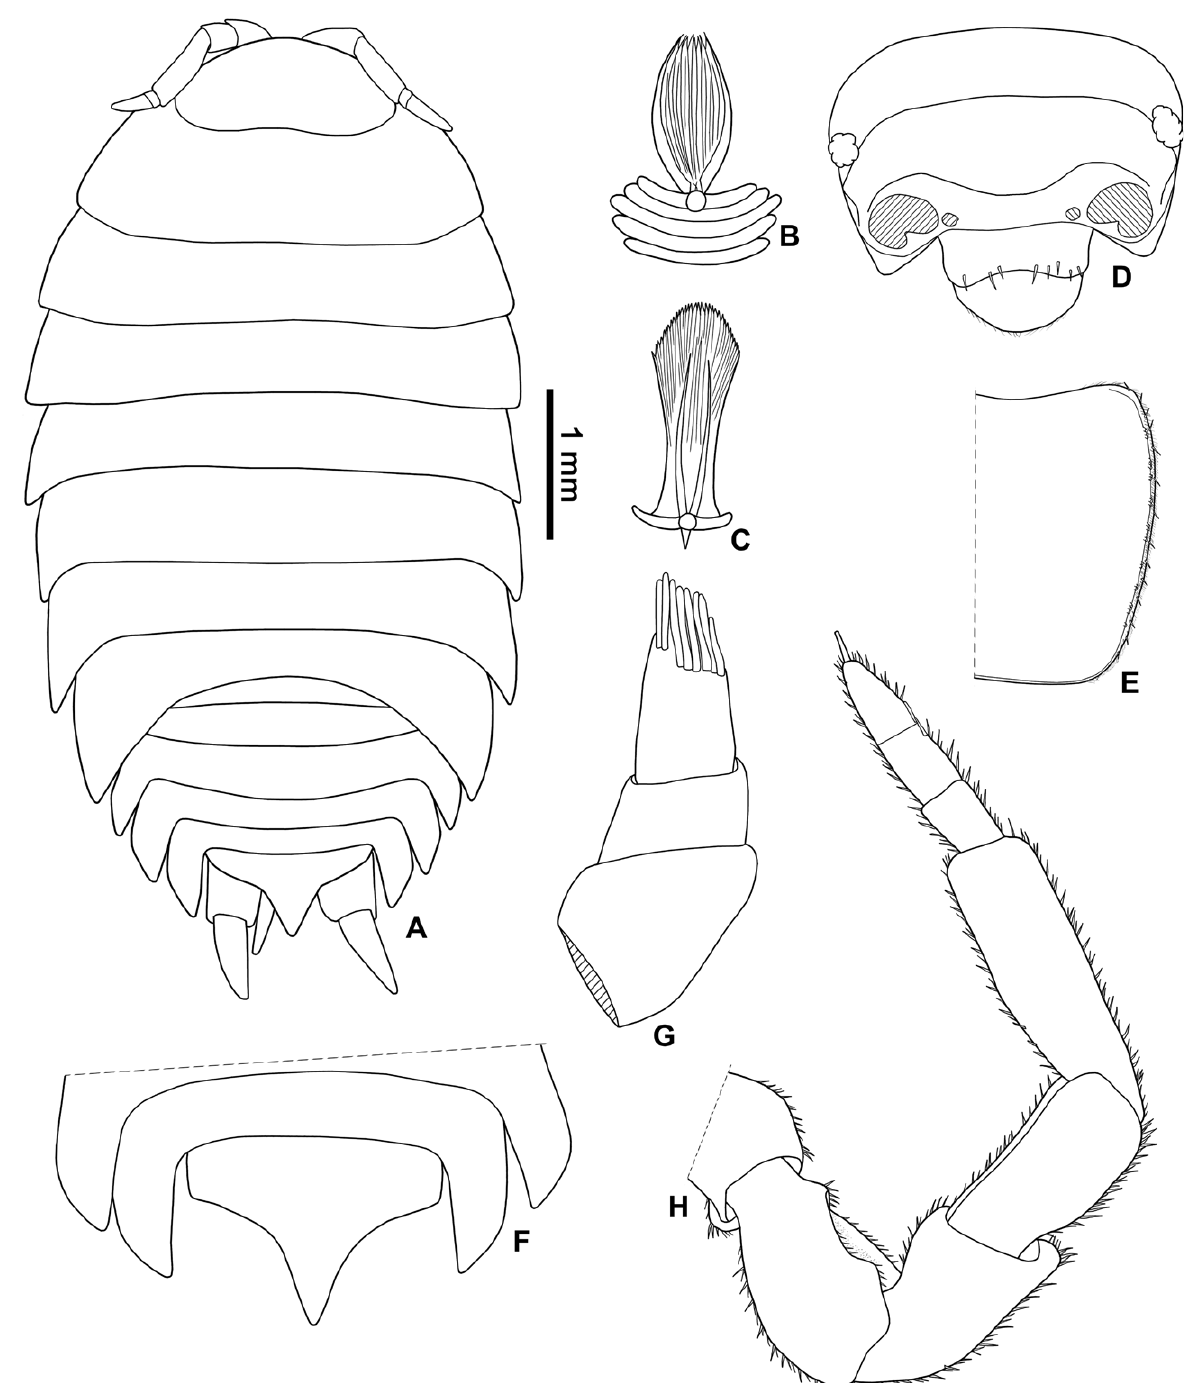
Figure 1. Alloniscus buckupi Campos-Filho & Cardoso n. sp., holotype. A, habitus, dorsal view; B, dorsal scale-seta; C, posterior scale- seta of pereonites; D, cephalon in frontal view; E, pereonite 1 epimeron; F, pleonites 4 and 5, and telson; G, antennula; H,